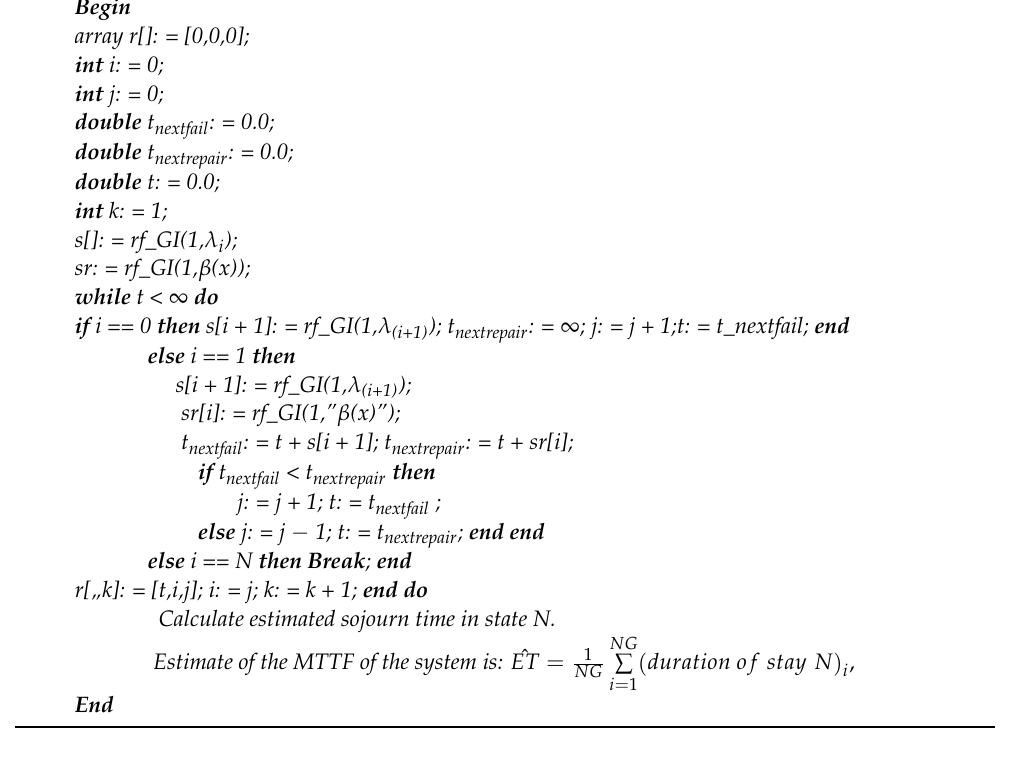
Algorithm A2 . The simulation pseudocode for the system < GI 2 / GI